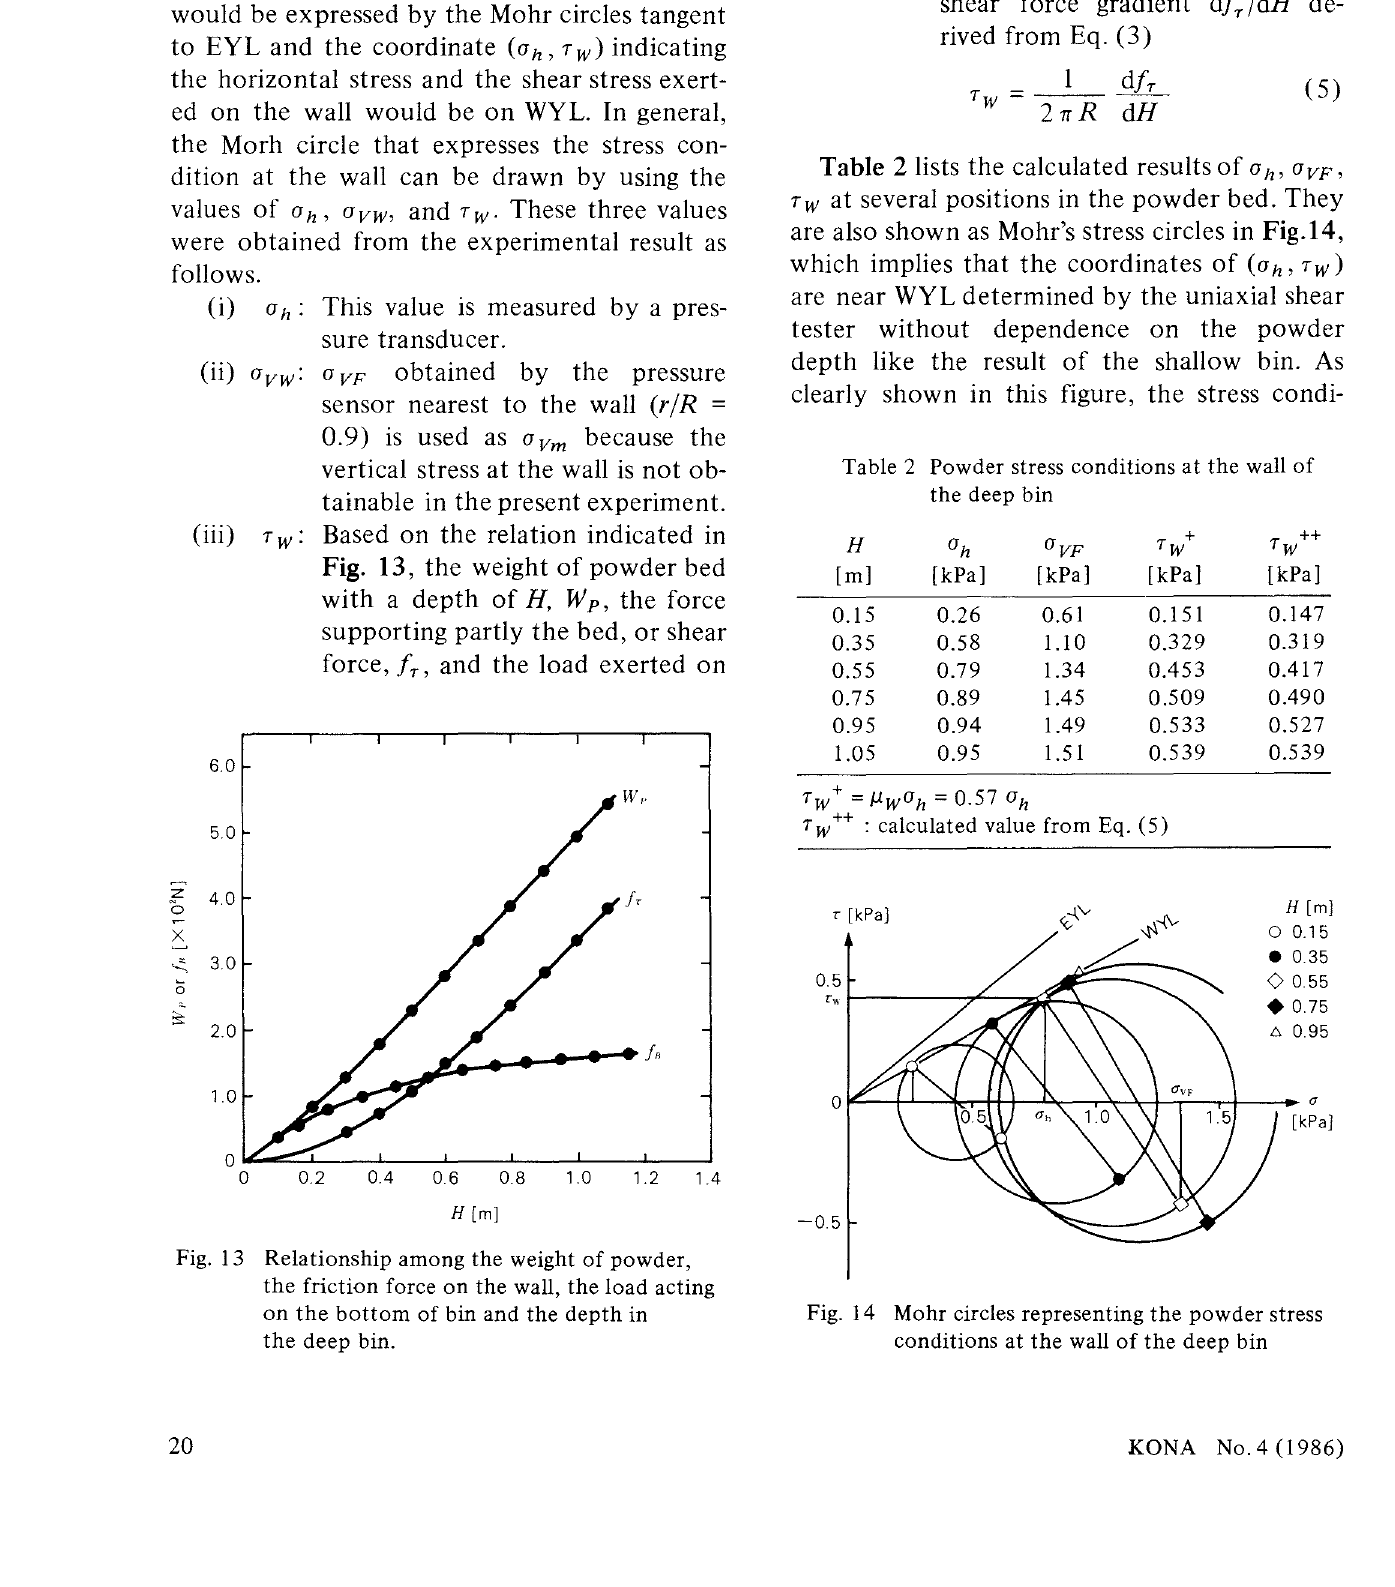
Fig. 13 Relationship among the weight of powder, the friction force on the wall, the load acting on the bottom of bin and the depth in the deep bin.